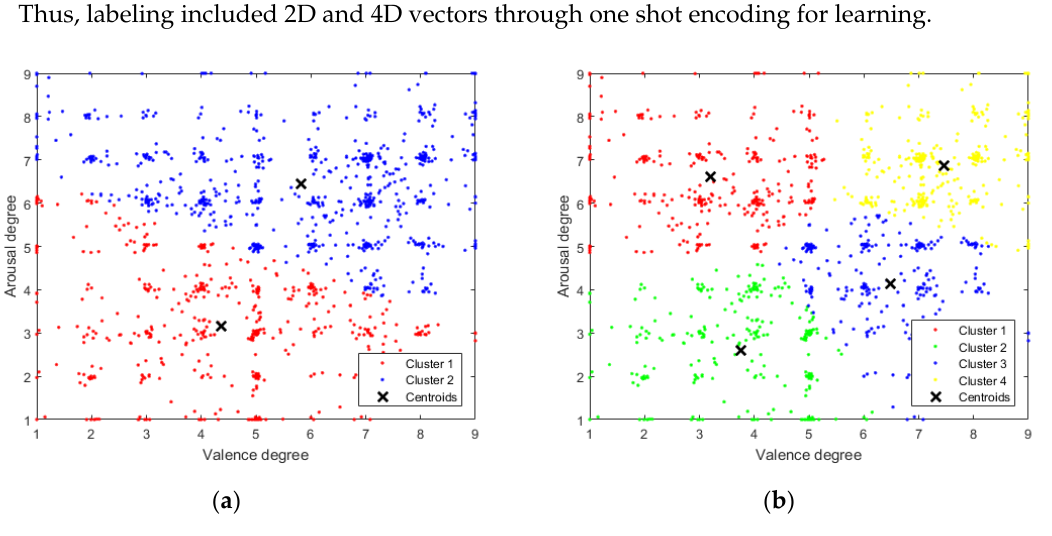
Figure 3. K-means clustering results of Arousal-Valence self-assessment data ( a ) Clustered Arousal-Valence data result when k = 2; and, ( b ) Clustered Arousal-Valence data result when k = 4.